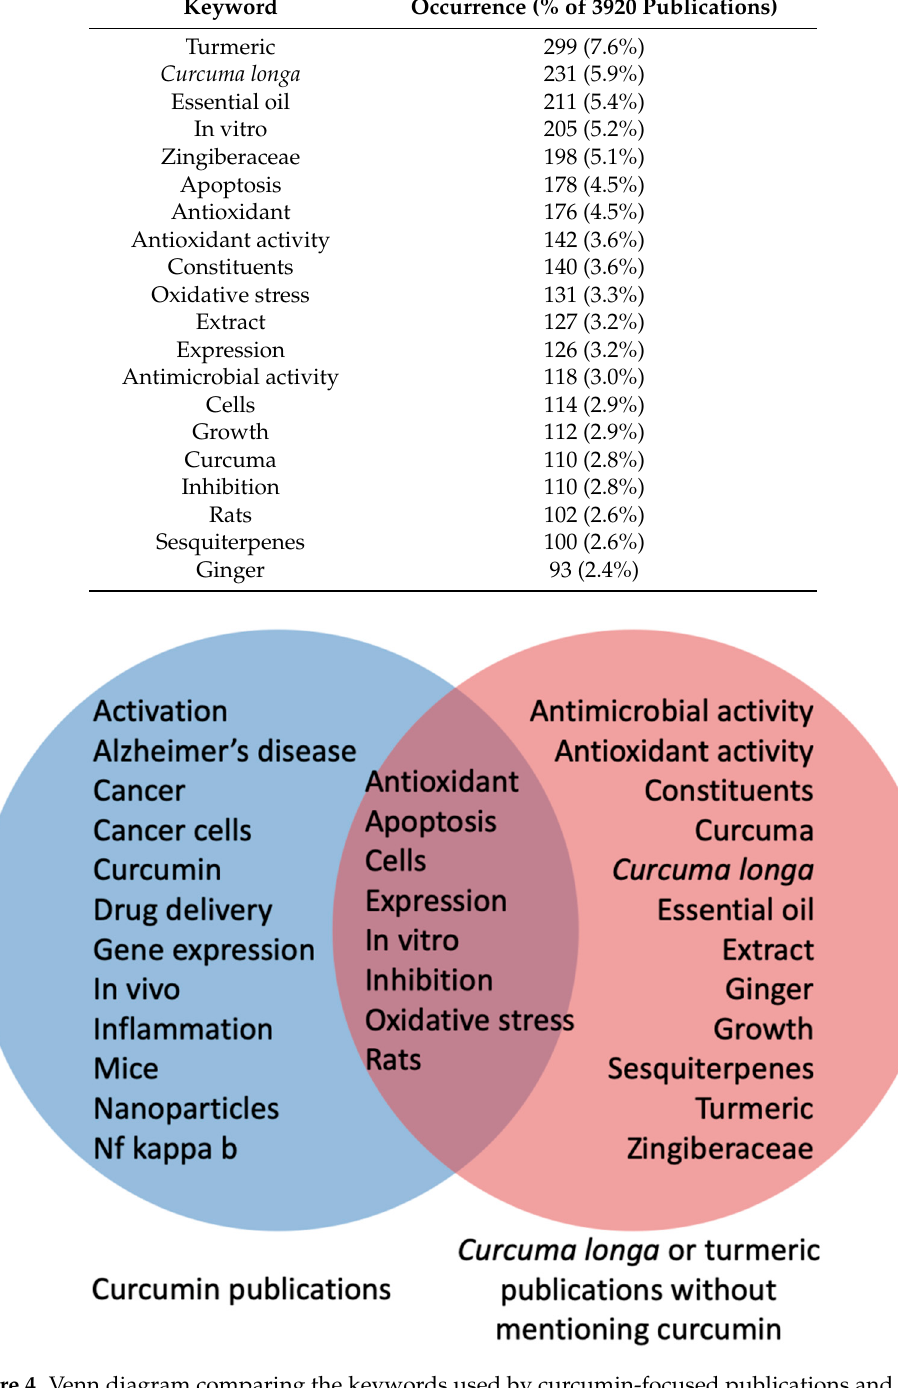
Figure 4. Venn diagram comparing the keywords used by curcumin-focused publications and those used by publications mentioning Curcuma longa or turmeric but not curcumin. Keywords from the former were more clinically relevant, whereas those from the latter were more related to plant science studies; commonly used keywords are presented in the middle of the diagram.